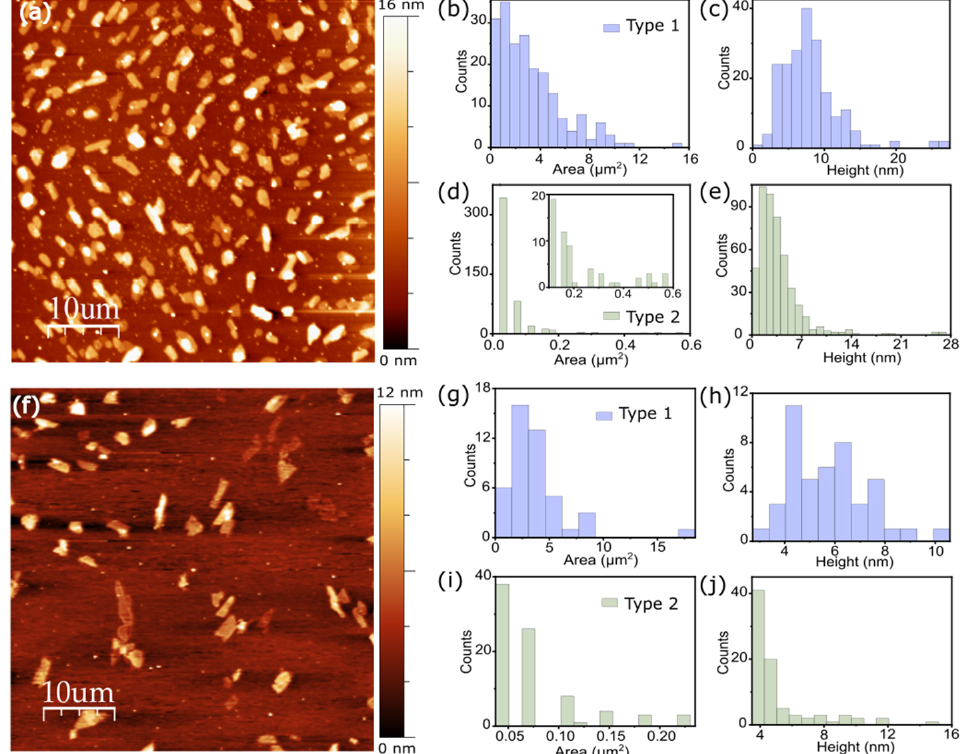
Figure 2. Atomic force microscopy (AFM) study of LPE cylindrite flakes. ( a ) AFM topographic characterization of cylindrite nanoflakes obtained in Sample 1. Image dimension: 50 × 50 µ m 2 . Statistical analysis of AFM area and height data of type 1 ( b , c ) and type 2 ( d , e ) cylindrite nanoflakes. ( f ) AFM topographic characterization of cylindrite nanoflakes obtained in Sample 3. Image dimension: 50 × 50 µ m 2 . Statistical analysis of AFM area and height data of type 1 ( g , h ) and type 2 ( i , j ) cylindrite nanoflakes.